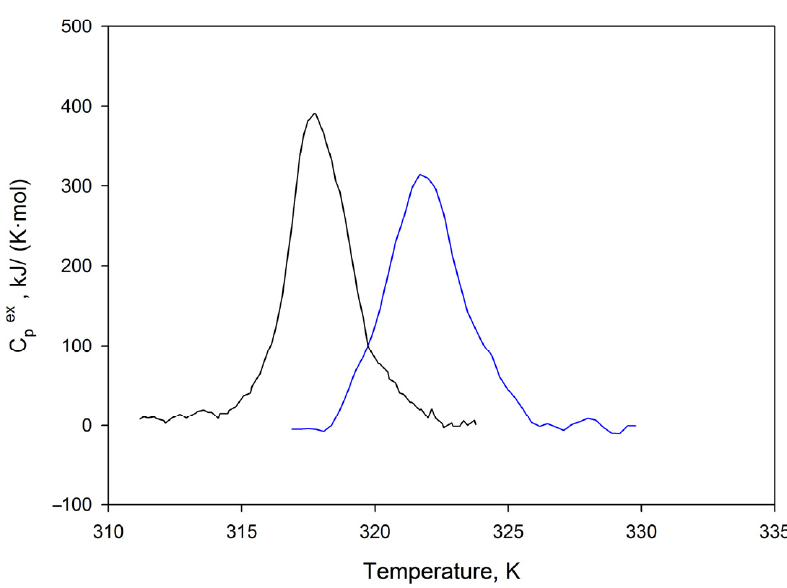
Figure 7. Typical temperature dependence of excess heat capacity of SMT HMW in monomeric (black) and aggregated (blue) forms. Experiments were carried out 2 times for both the monomeric and aggregated SMT HMW forms. The obtained curves coincided in temperature T m to an accuracy of 0.1 K. The relative error in determining calorimetric enthalpy, Δ Hcal, did not exceed 10%.